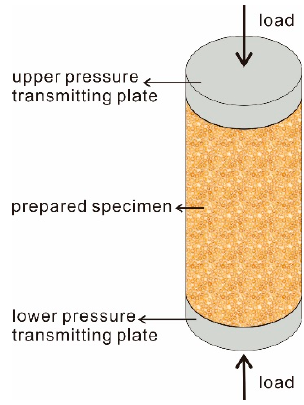
Figure 5. The diagrammatic sketch of the UCS test.